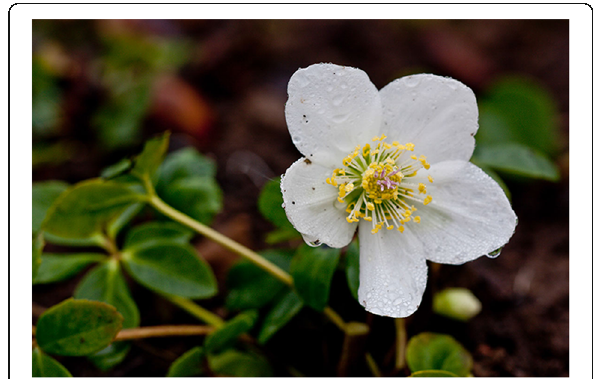
Fig. 1 Helleborus niger L. Black hellebore is a perennial herb with a shallow rhizome blossoming during winter. Taxonomically it is grouped with the Ranunculaceae. Black hellebore has been used as a remedy since ancient times. Because of the multiple components, a broad pharmacological spectrum is ascribed to Christmas rose: anti-bacterial, anti-inflammatory, cholesterol- and blood glucose- lowering, neuroprotective, hepatoprotective and immune- modulating effects. With respect to pharmacologically active ingredients, four compound classes are particularly relevant,